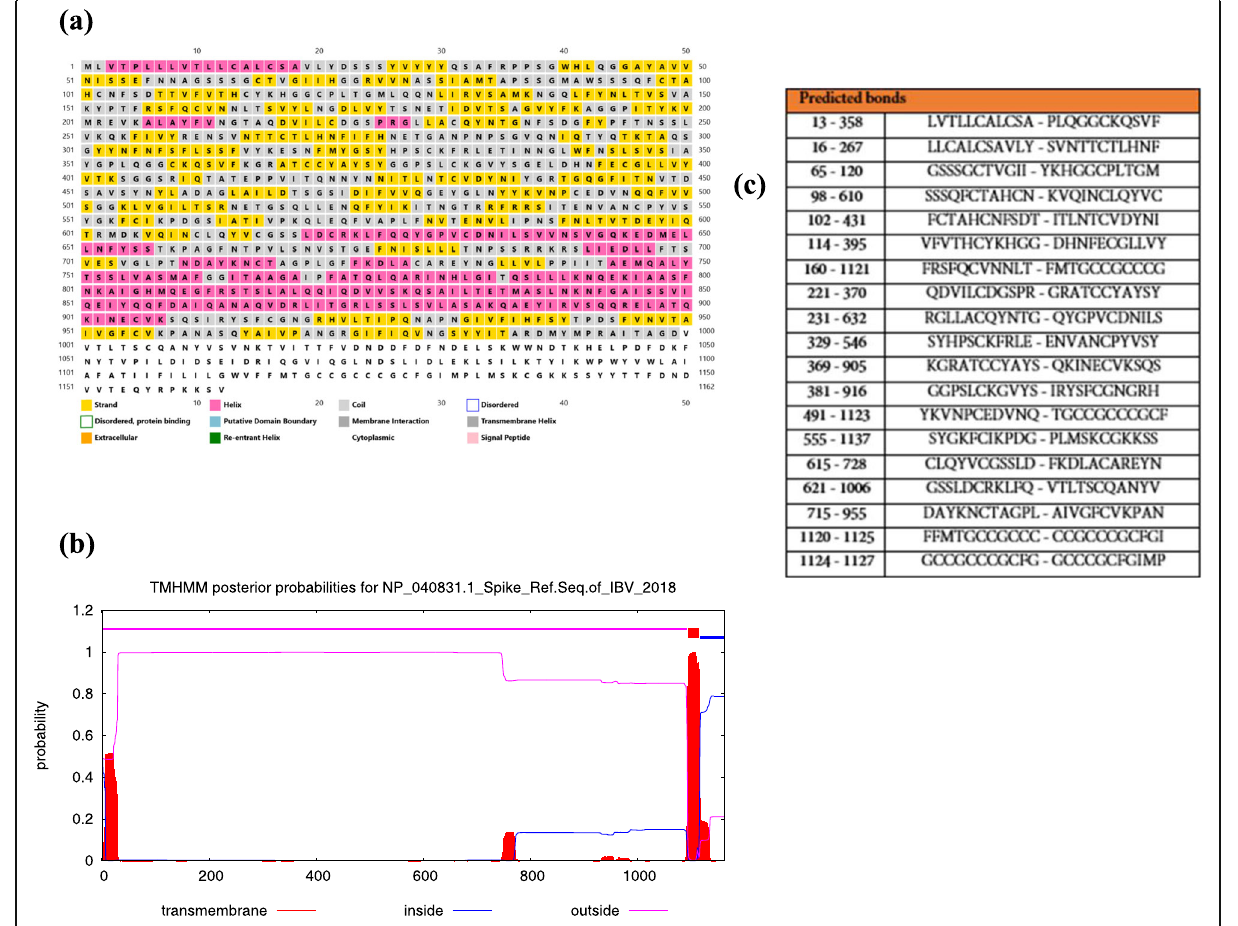
Fig. 1 ( a ): The secondary structure of IBV spike protein; ( b ): transmembranr topology of spike protein; ( c ): the position of disulphides bond (S –